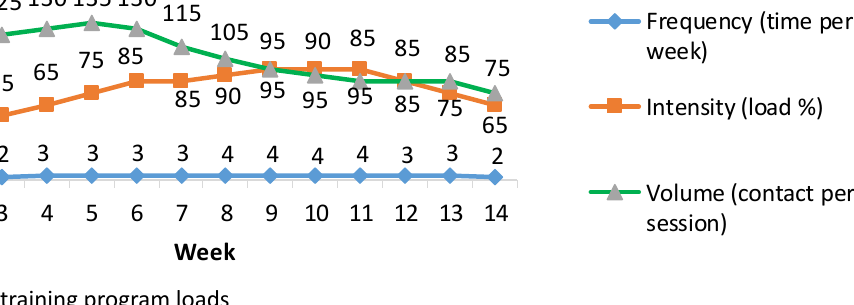
Figure 1. Plyometric training program